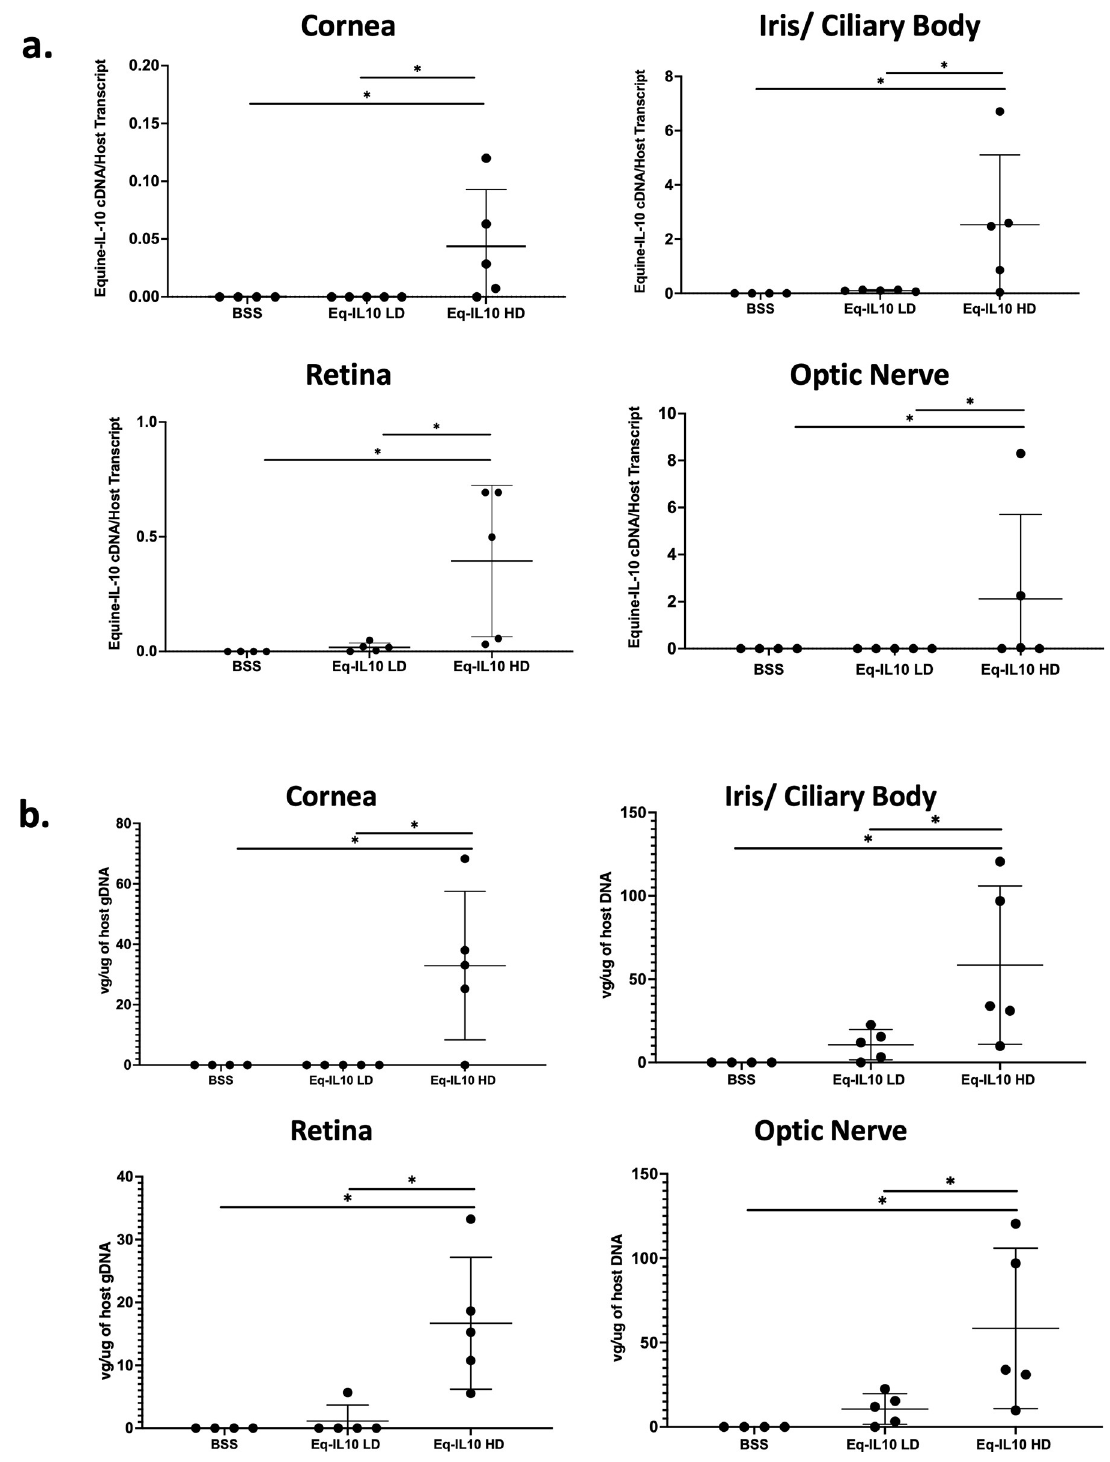
Fig 4. AAV8-Equine-IL10 expression and ocular distribution. (a) Equine-IL10 abundance examination by qRT-PCR in selected tissues are presented as vector cDNA /host transcript (GAPDH), One-way ANOVA ( � p < 0.01). Results represent experiments done in triplicate with mean value expressed. LD = low dose; HD = high dose; Conjunctival tissues were negative in all groups; (b) Vector genome copy number in distinct ocular tissues are shown as vector genome copy number/ug of host genome DNA, One-way ANOVA ( � p <